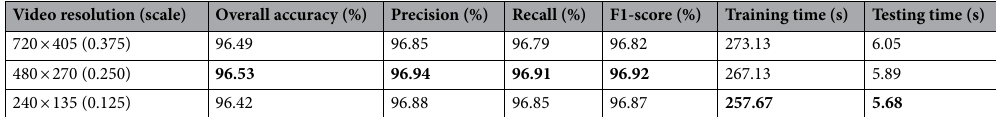
Table 6. Performance metrics for dynamic signs at 200 Bags. Significant values are in